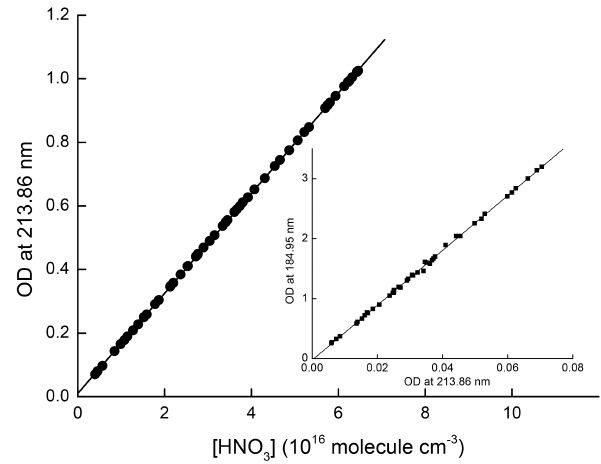
Figure 2. Beer–Lambert plot used for the calculation of the HNO 3 absorption cross section at 213.86nm, σ 213 . 86nm . The inset shows the linear relation between optical densities (OD) at 184.95nm (op- tical path length = 43 . 8cm) and 213.86nm (optical path length = 34 .